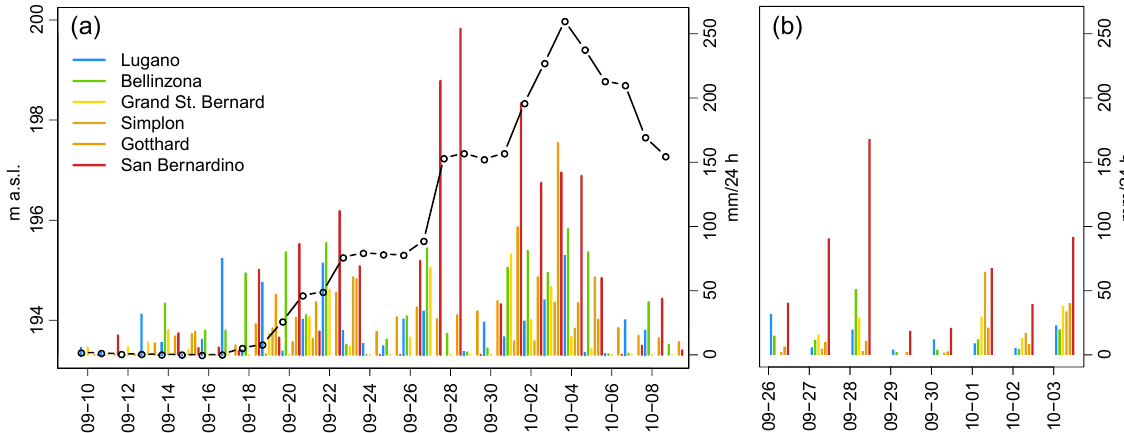
Figure 4. (a) Mean daily lake level of Lago Maggiore (ma.s.l.; black line) and observed daily precipitation (mm24h − 1 ; from 05:40 to 05:40 LT the following day) at six rain gauge stations between 10 September 1868 and 10 October 1968. (b) Simulated daily precipitation (mm24h − 1 ; from 06:00 to 06:00UTC the following day) at the locations of panel (a) . Note that the Simplon Pass observations have missing data, and that the time axis and spacing differ between panels (a) and (b) .